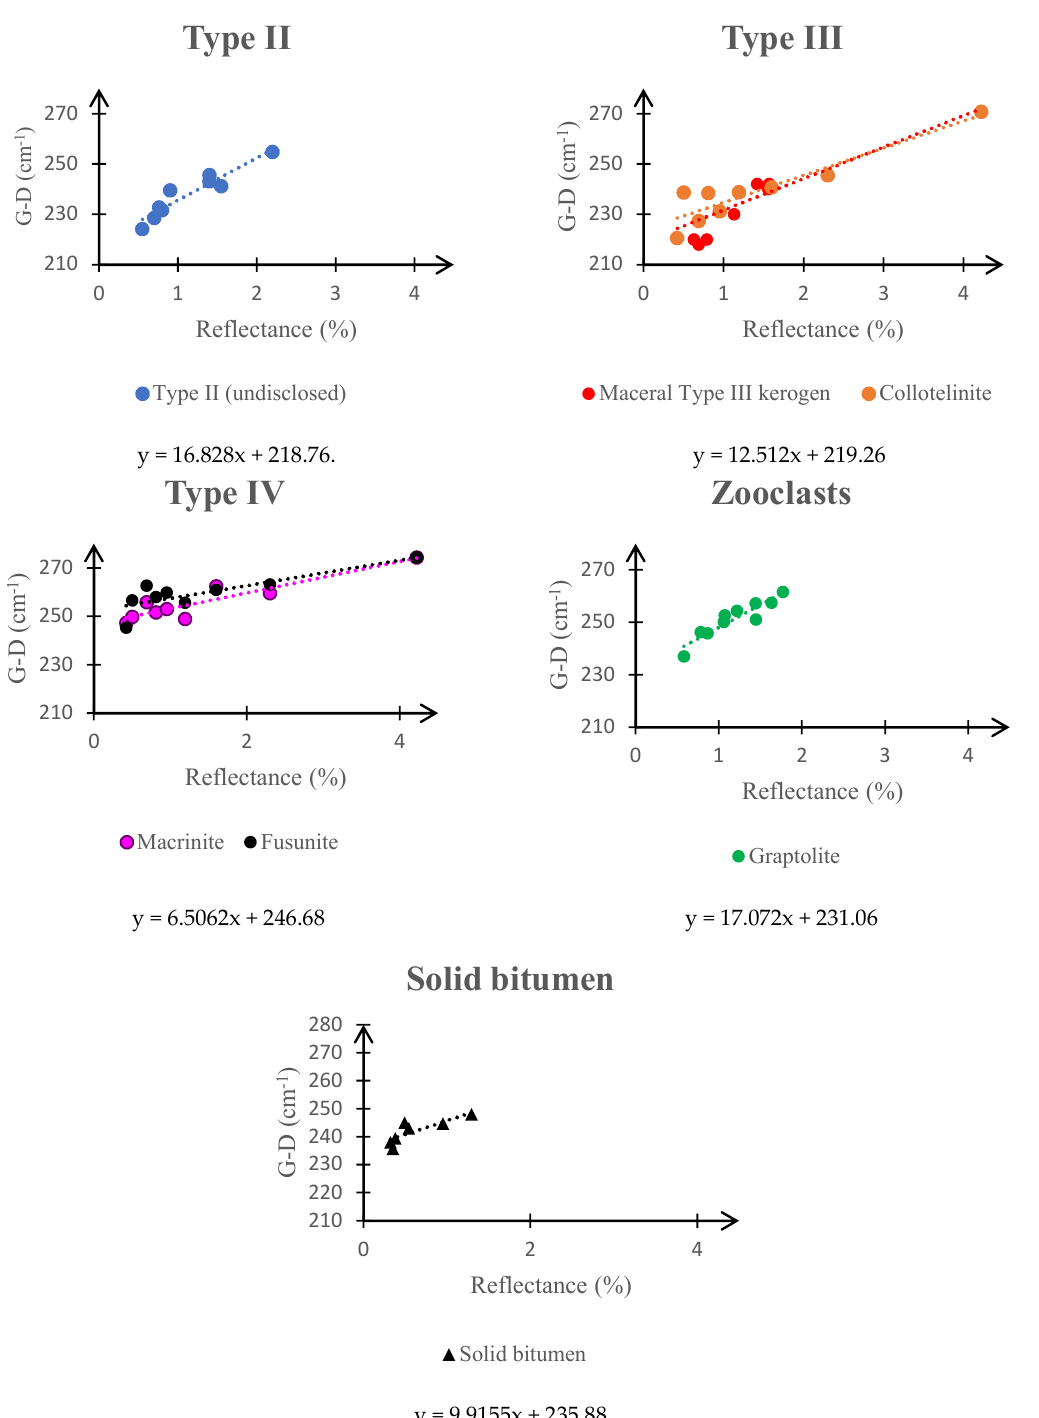
Figure 5. Comparison of band separation and reflectance of several OM types. Data are extracted from other researches [43,50,63] acquired by the 632 nm laser wavelength.